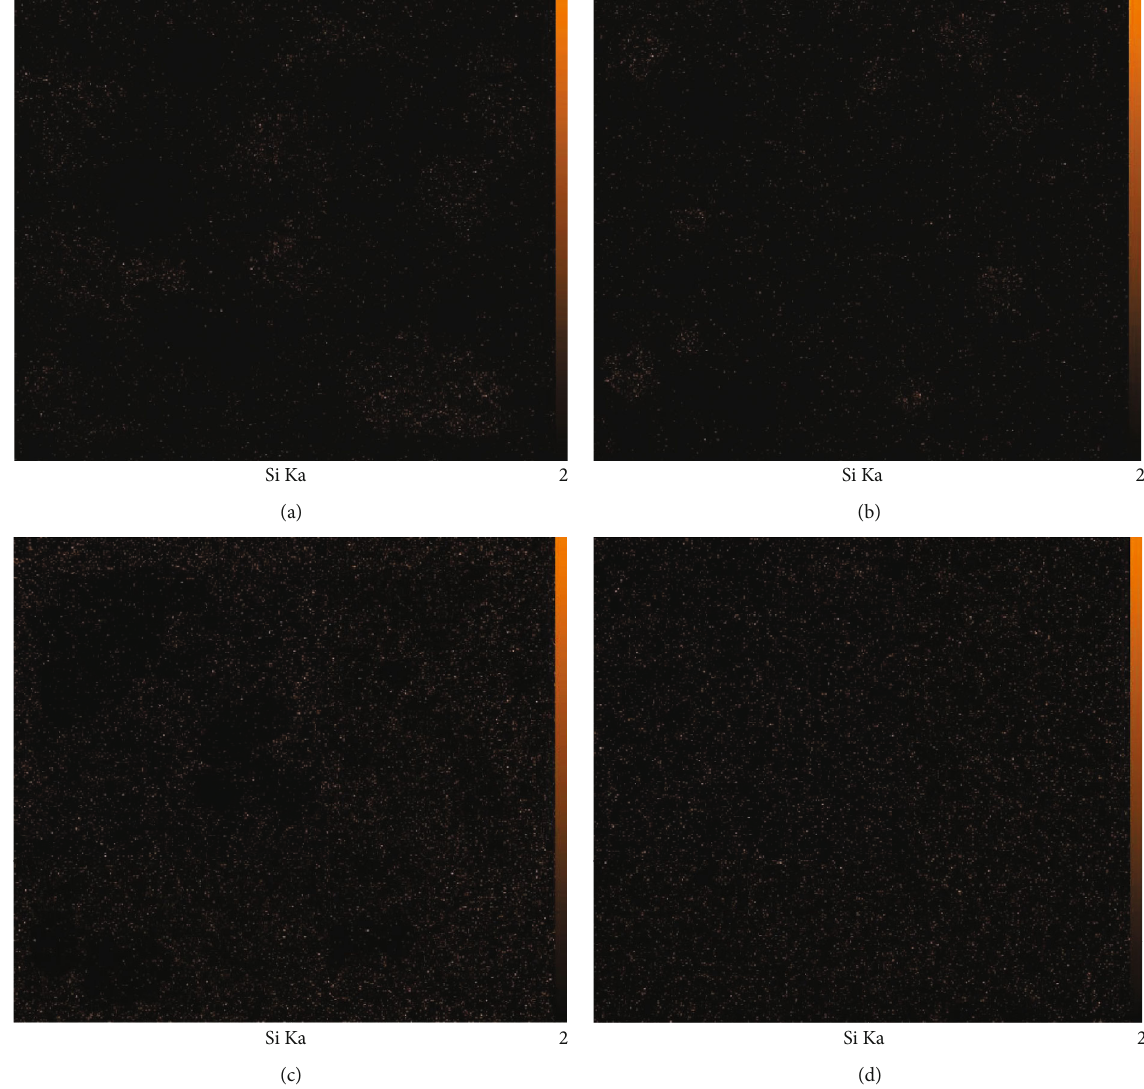
Figure 6: Silica mapping in (a) S-SSBR, (b) Si69-SSBR, (c) T-SSBR, and (d)